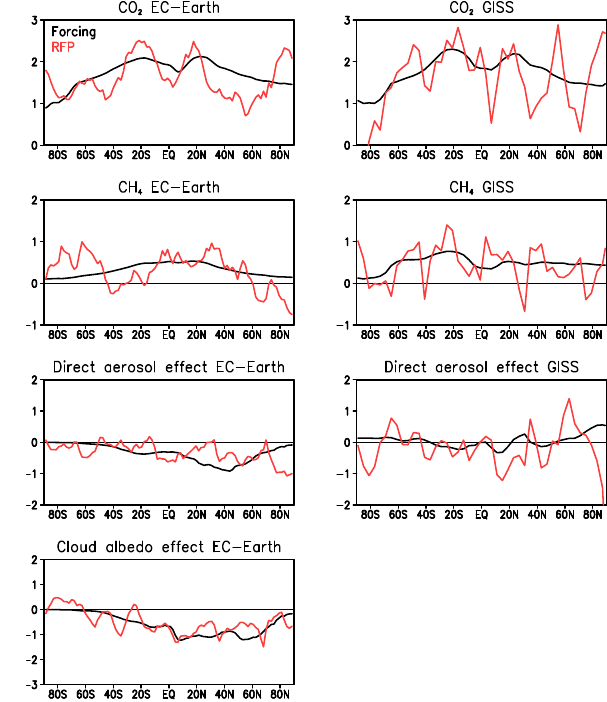
Fig. 5. Annual zonal means of RFP vs. F [Wm − 2 ] for the different forcing agents from the EC-Earth and GISS GCMs.